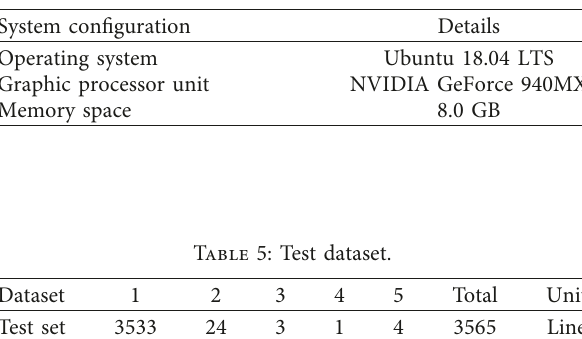
Figure 9: Establishment process of sandstorm prediction model based on INB-CNN classification algorithm. Table 4: Experimental environment configuration.